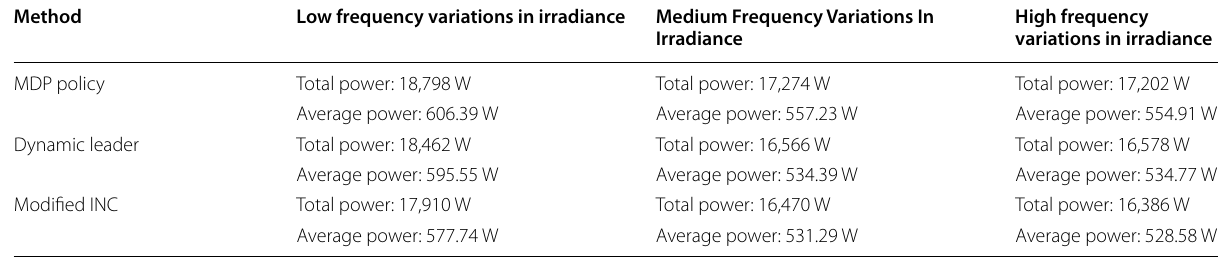
Table 4 Comparison of power delivered to the load under different irradiance variations